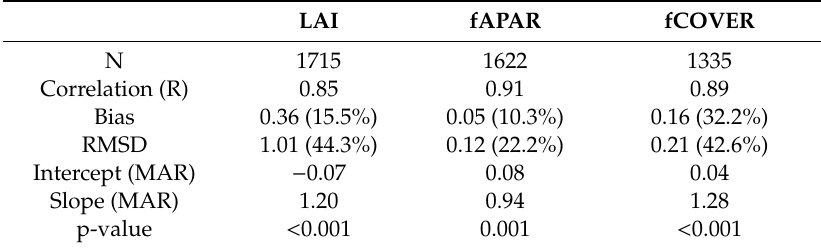
Figure 7. PROBA-V Collection 300 m V1 products against ground-based maps for LAI ( a ), fAPAR ( b ) and fCOVER ( c ). Numbers identify the ground data. Dashed lines correspond to the 1:1 line and optimal and target requirements, and the red line corresponds to the linear fit using Major Axis Regression (MAR). Each point represents the mean value, and error bars correspond to the standard deviation. Numbers identify the sample (Table 2), and colours identify the site. Statistics of the comparisons are reported in Table 9. Table 9. Accuracy assessment statistics for PROBA-V Collection 300 m V1 products. Relative values (%) are shown in